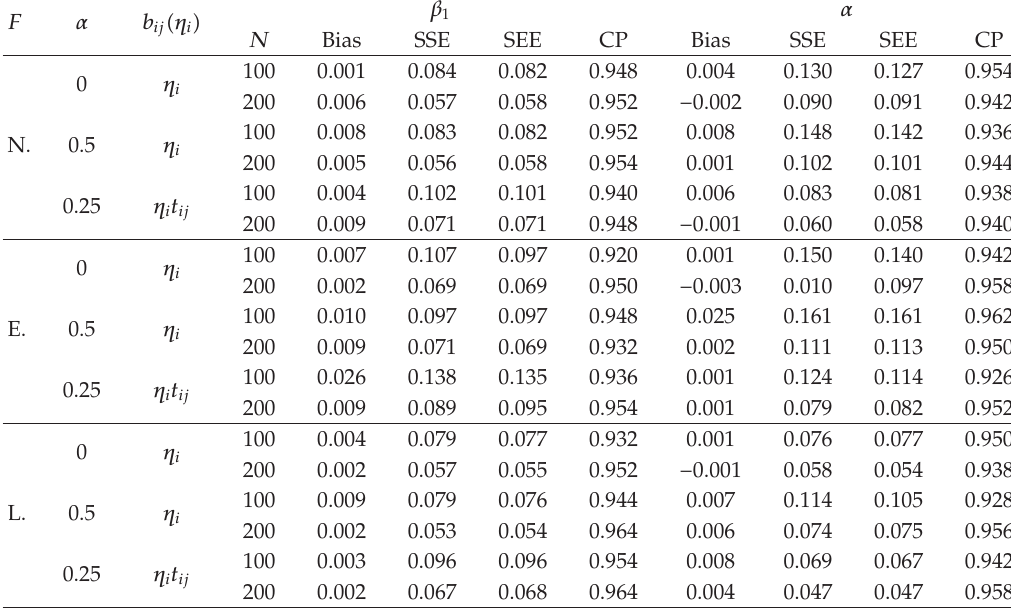
Table 1: Simulation results for pure informative dropouts.